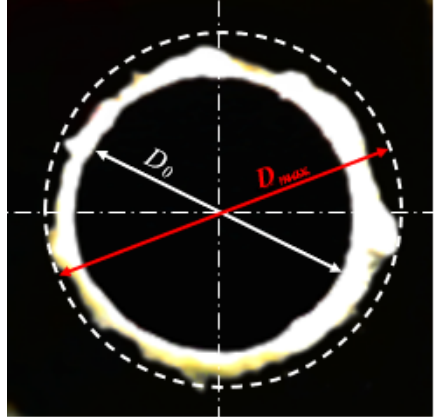
Figure 2. Image indicates the push-out delamination in drilling FRP composites. Influences of drilling parameters, drill point angle, and laminated thickness on the push-out delamination are presented in Table 5, and their quantitative presentation is shown in Figure 3. As shown in this figure, by increasing the point angle of the drill, the push-out delamination increased significantly by increasing the feed. As the case in hand at speed 400 rpm, feed 0.2 mm/r and thickness of 2.6 mm, the variation in drill point angle from 100 ◦ to 118 ◦ to 140 ◦ , and the delamination factor increased from 1.49 to 1.53 to 1.62, respectively. The same observation has been reported [4,41]. It is also noted that the delamination factor is proportional to feed and speed. However, the thickness has a trivial and marginal influence on the delamination factor. Table 5. The variation of delamination with speed, feed, thickness, and point